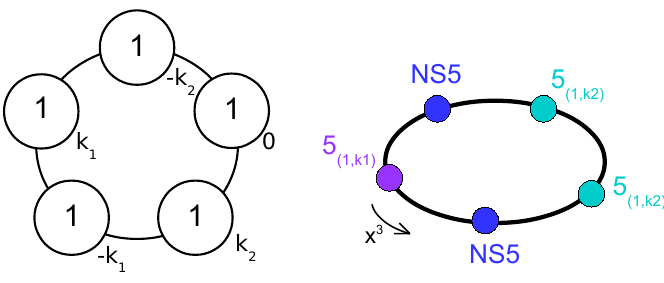
Figure 35 . Quiver and brane realization of the T circ